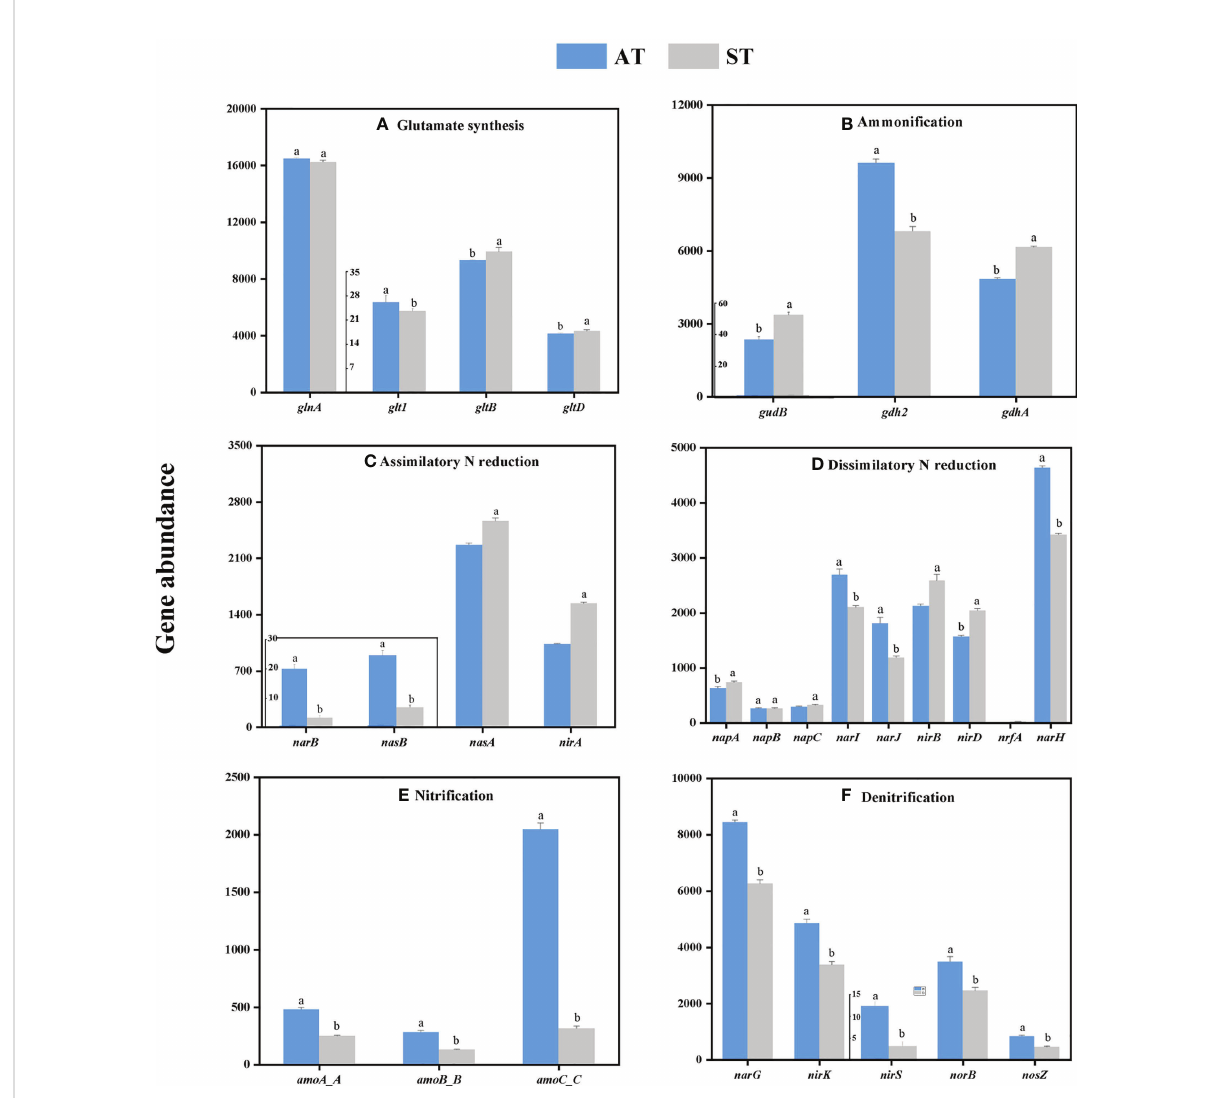
FIGURE 3 The abundance of individual genes involved in each N-cycle processes (A – F) with different acidity of tea soils. AT, tea soil with a pH of 3.75; ST, tea soil with a pH of 5.26. Bars indicate standard error of the mean (n = 3). Different lowercases represent signi fi cant differences at P < 0.05